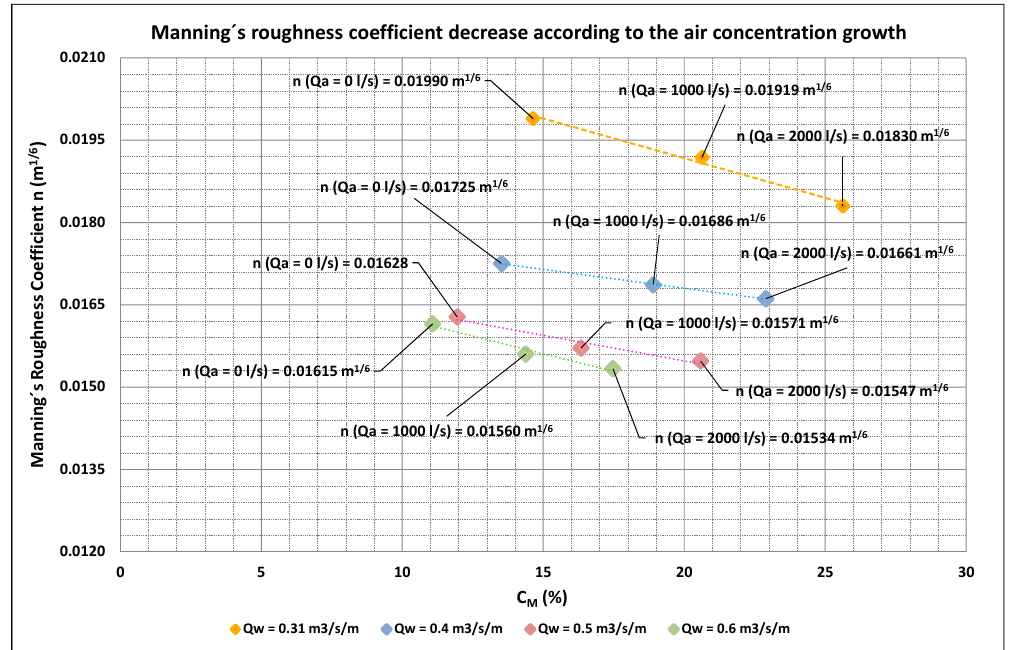
Figure 14. The relation between Manning’s roughness coefficient (n) and average air concentration (C M ) for all scenarios.